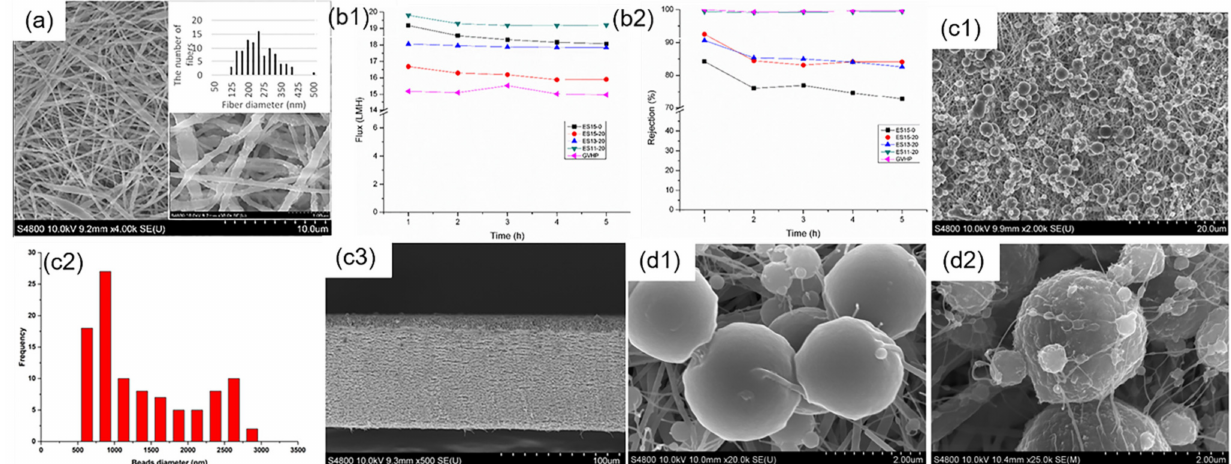
Figure 5. ( a ) SEM images of optimized fibers; ( b1 , b2 ) Flux data and rejection percentage as a function of time for the commercial and the synthesized membranes; Reprinted with permission from Ref. [82]. 2017, Elsevier. ( c1 – c3 ) SEM images of top surface, beads diameter and cross-section of the optimized PVDF/Al 2 O 3 ENMs; ( d1 , d2 ) SEM images of beads without and with 30 wt% Al 2 O 3 nanoparticles. Reprinted with permission from Ref. [83]. 2018,